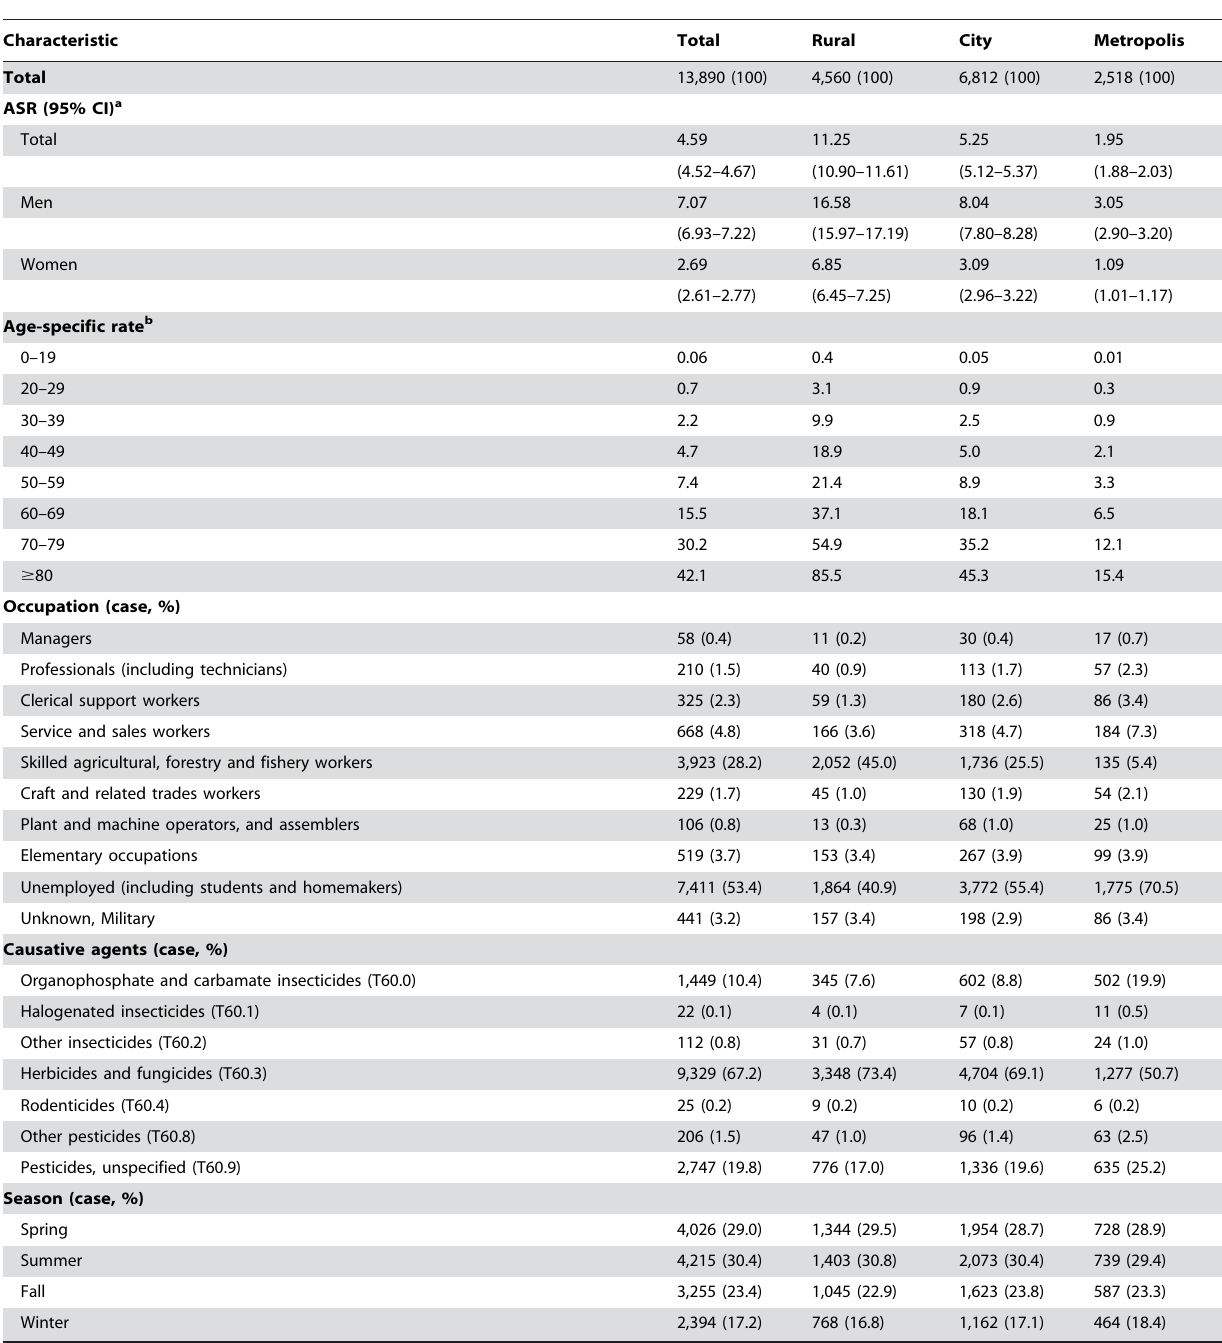
Table 3. Geographic difference of intentional pesticide poisoning in South Korea,